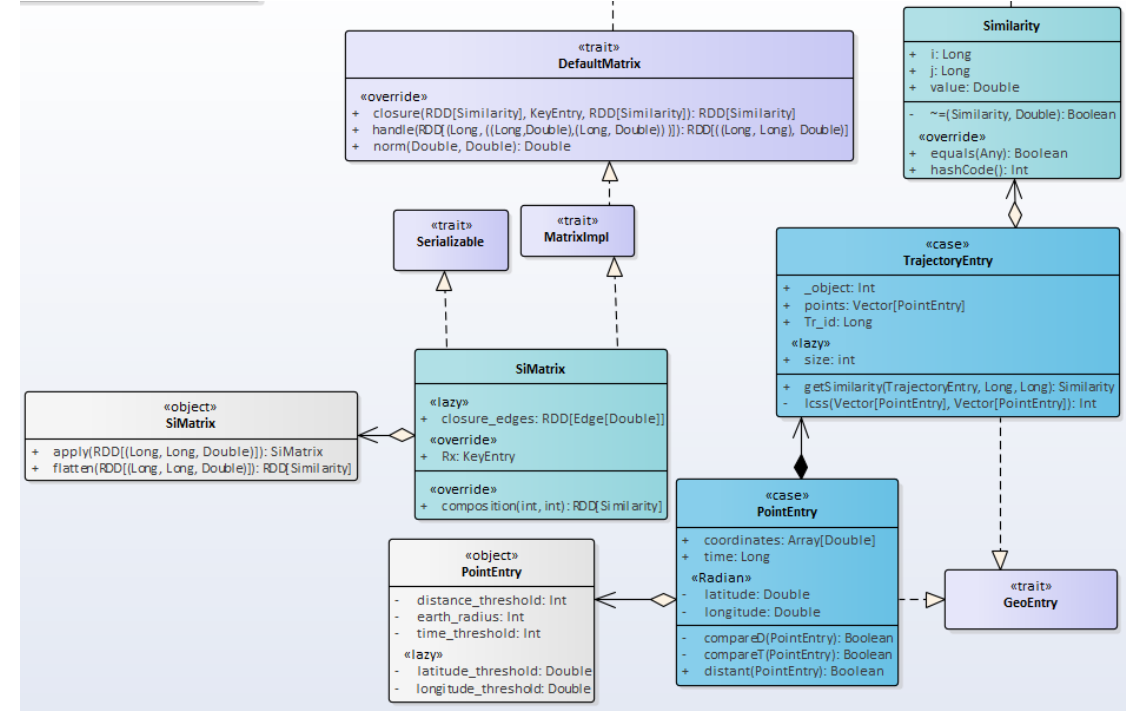
Figure 2. The implementation of the AbstractMatrix